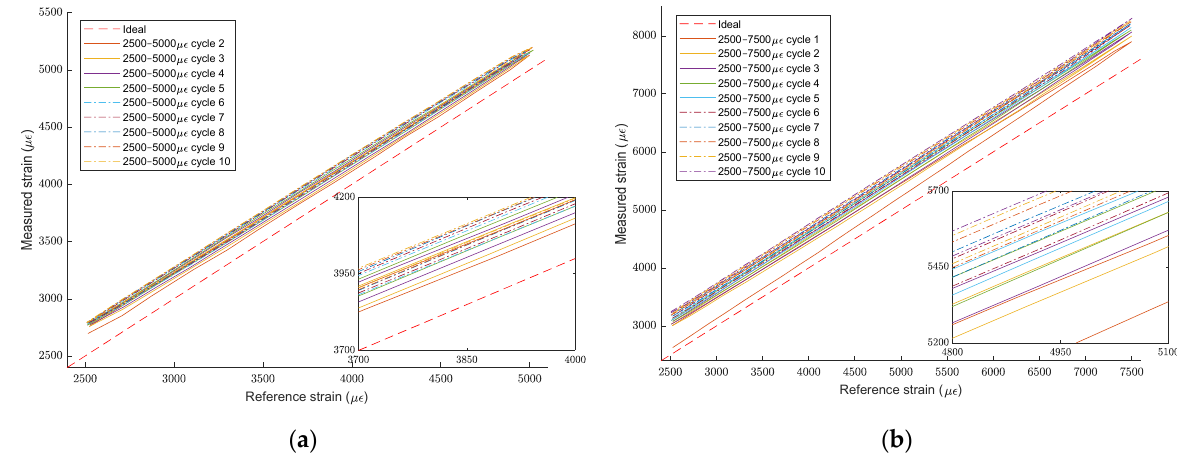
Figure 9. Sensor 3 strain readings: ( a ) accuracy at 0.25–0.50% strain cycles; ( b ) accuracy at 0.25–0.75% strain cycles.